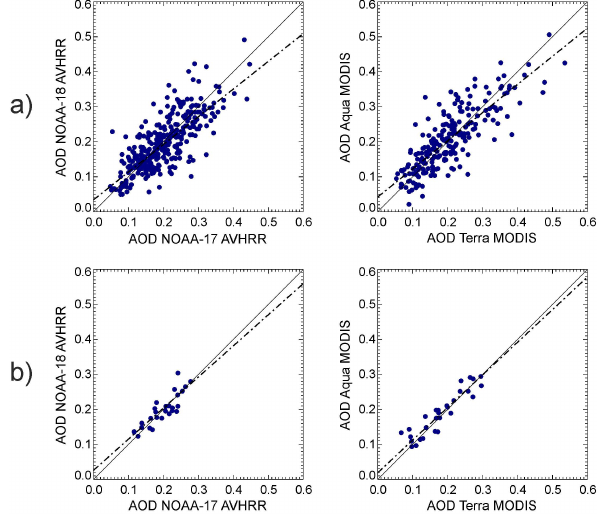
Fig. 9. Scatter plots of the intersatellite comparisons of monthly average τ a between NOAA-17 and NOAA-18, Terra and Aqua, re- spectively. The plots in (a) show the individual monthly averages of each site in Table 1 separately. For the aggregated values (b) , all sites are averaged for a particular month. Statistical results can be found in Table